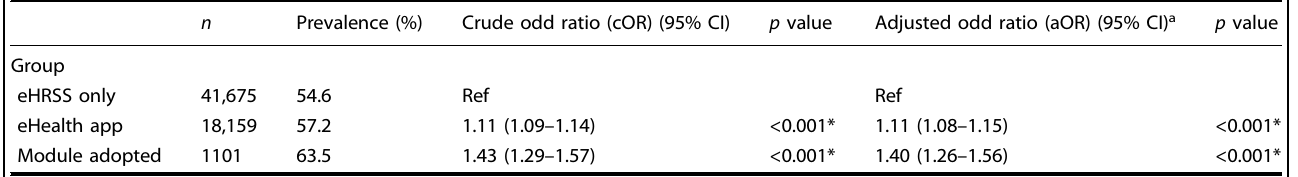
Table 2. Factors associated with optimal control of HbA1c in all